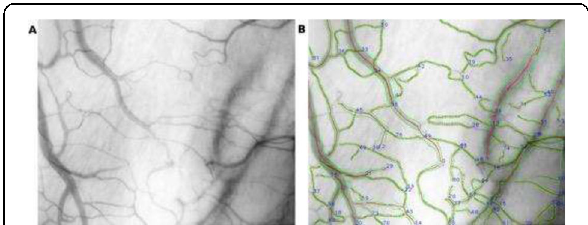
Fig. 1 (abstract 0333) Capillary detection (B) in an averaged video frame (A) using advanced computer vision.